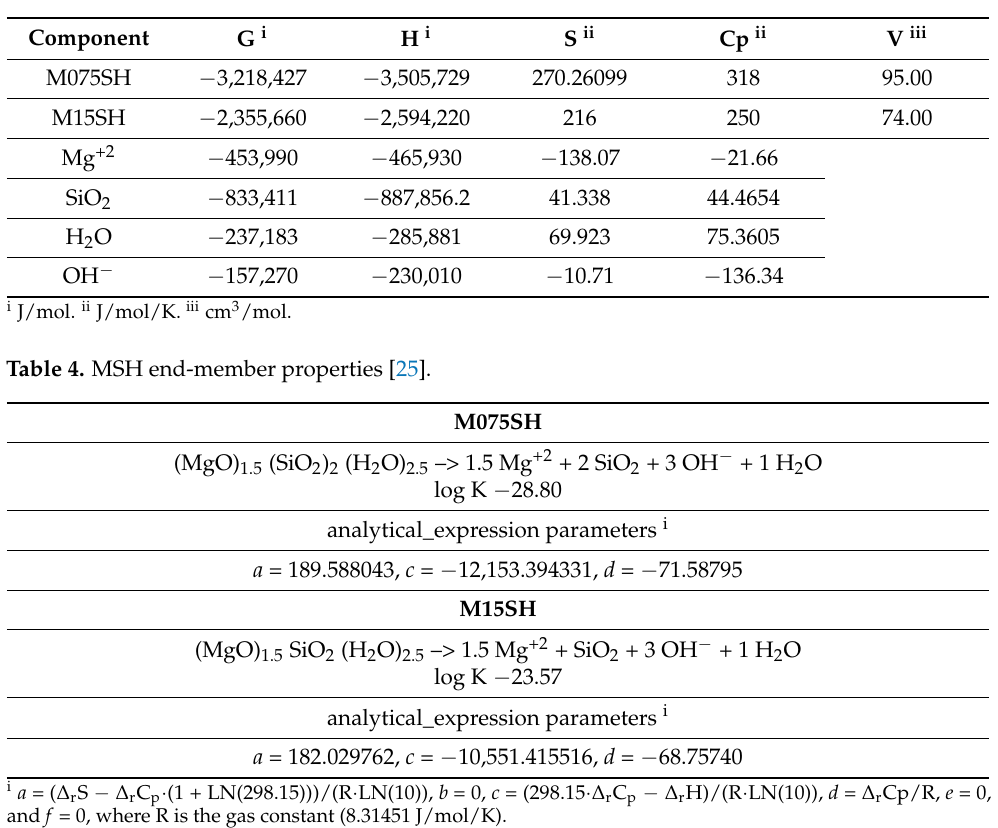
Table 3. Thermodynamic properties of M-S-H as taken from [25].